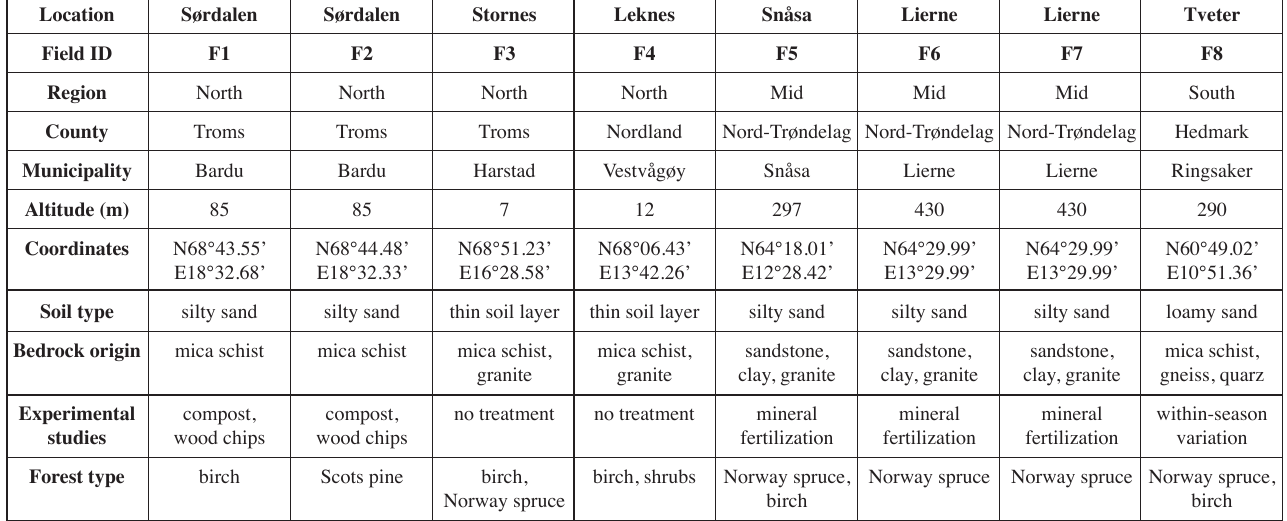
Tab. 1: Description of experimental forest fields in